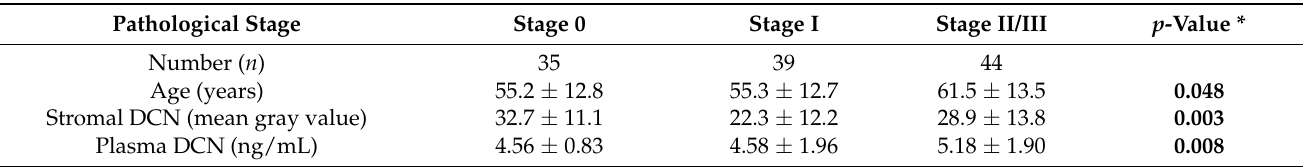
Table 1. Comparison of stromal and plasma DCN, age, and biological features in different pathological stages. Pathological Stage Stage 0 Stage I Stage II/III p -Value * Number ( n ) 35 Age (years) Stromal DCN (mean gray